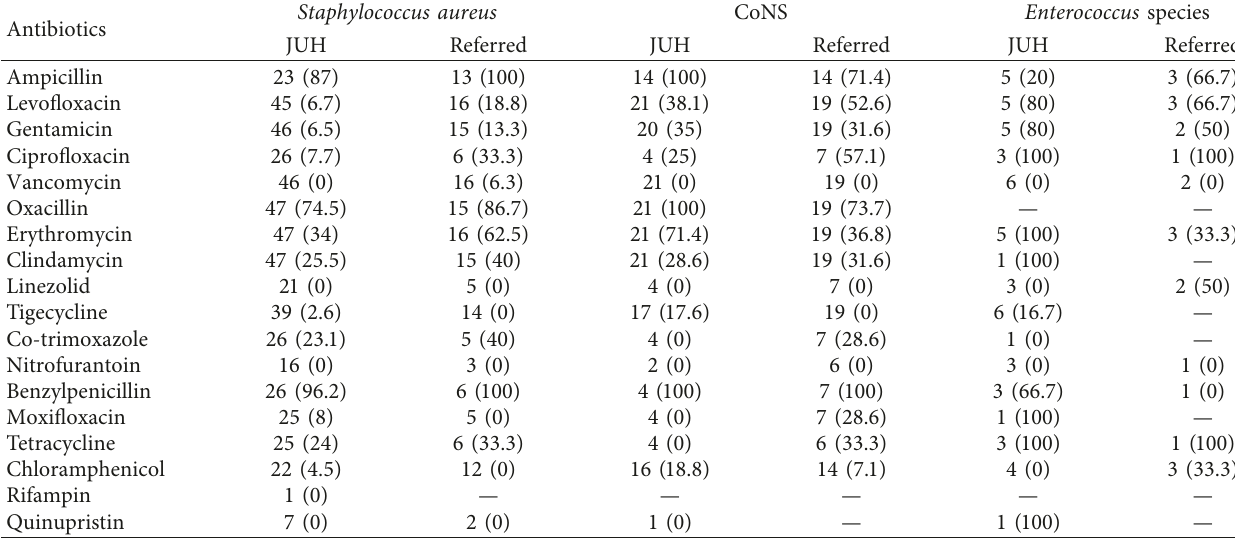
Table 5: Comparison between the resistance pattern according to the source of infection for the most common bacteria.